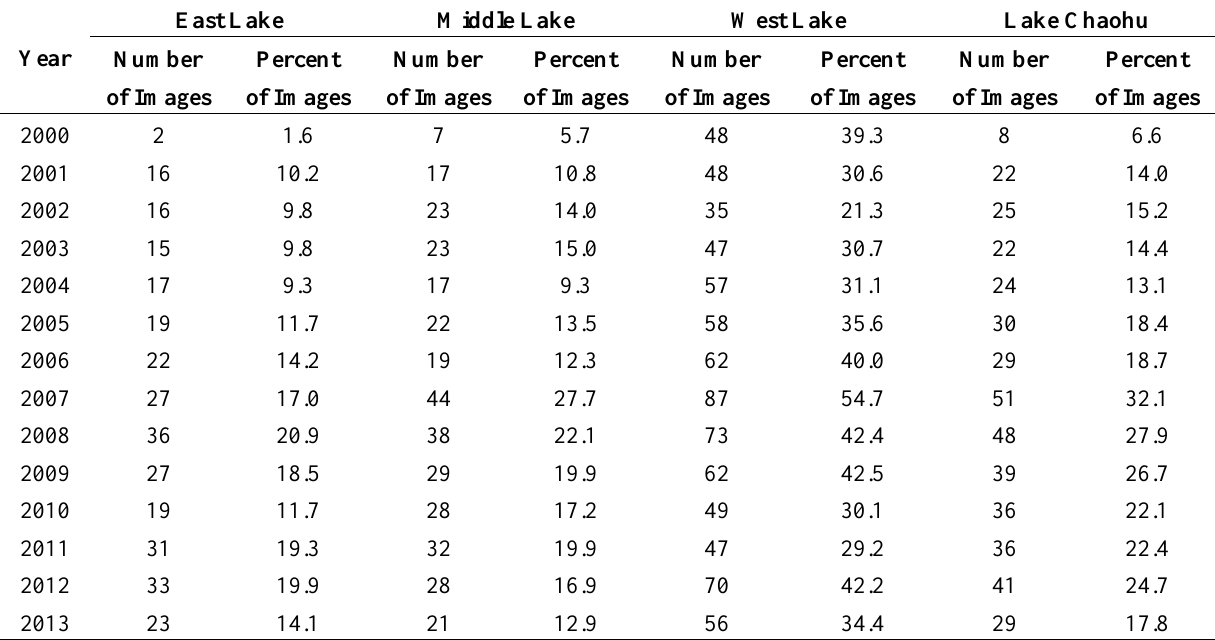
Table 1. Frequency of significant floating algae blooms in each lake segment of Lake Chaohu * .